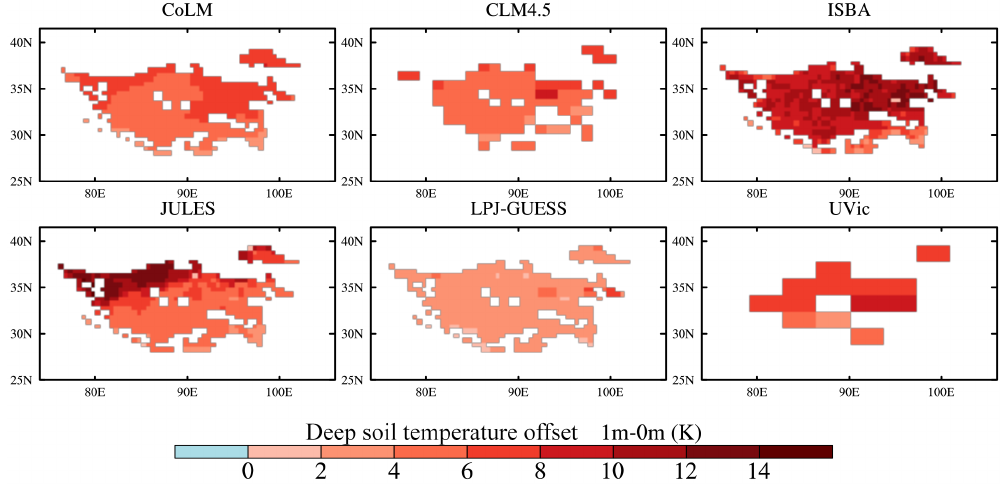
Figure 8. Mean soil temperature offset: difference in mean winter temperatures between soil at 1m depth and surface soil, averaged over 1980–2000. Warm colors indicate deep soil is warmer than shallow